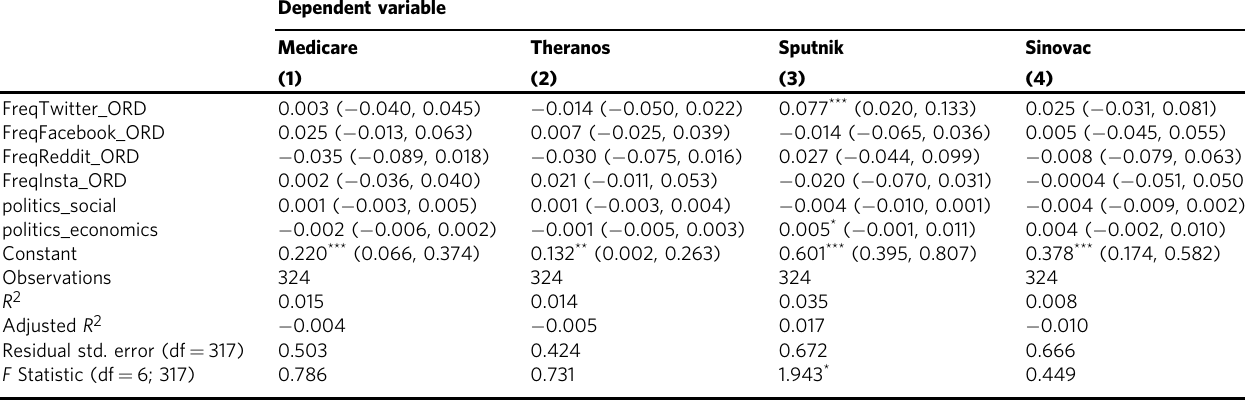
Table 2 Regressions for reported knowledge of unavailable (fake) vaccines, Sputnik, and Sinovac.